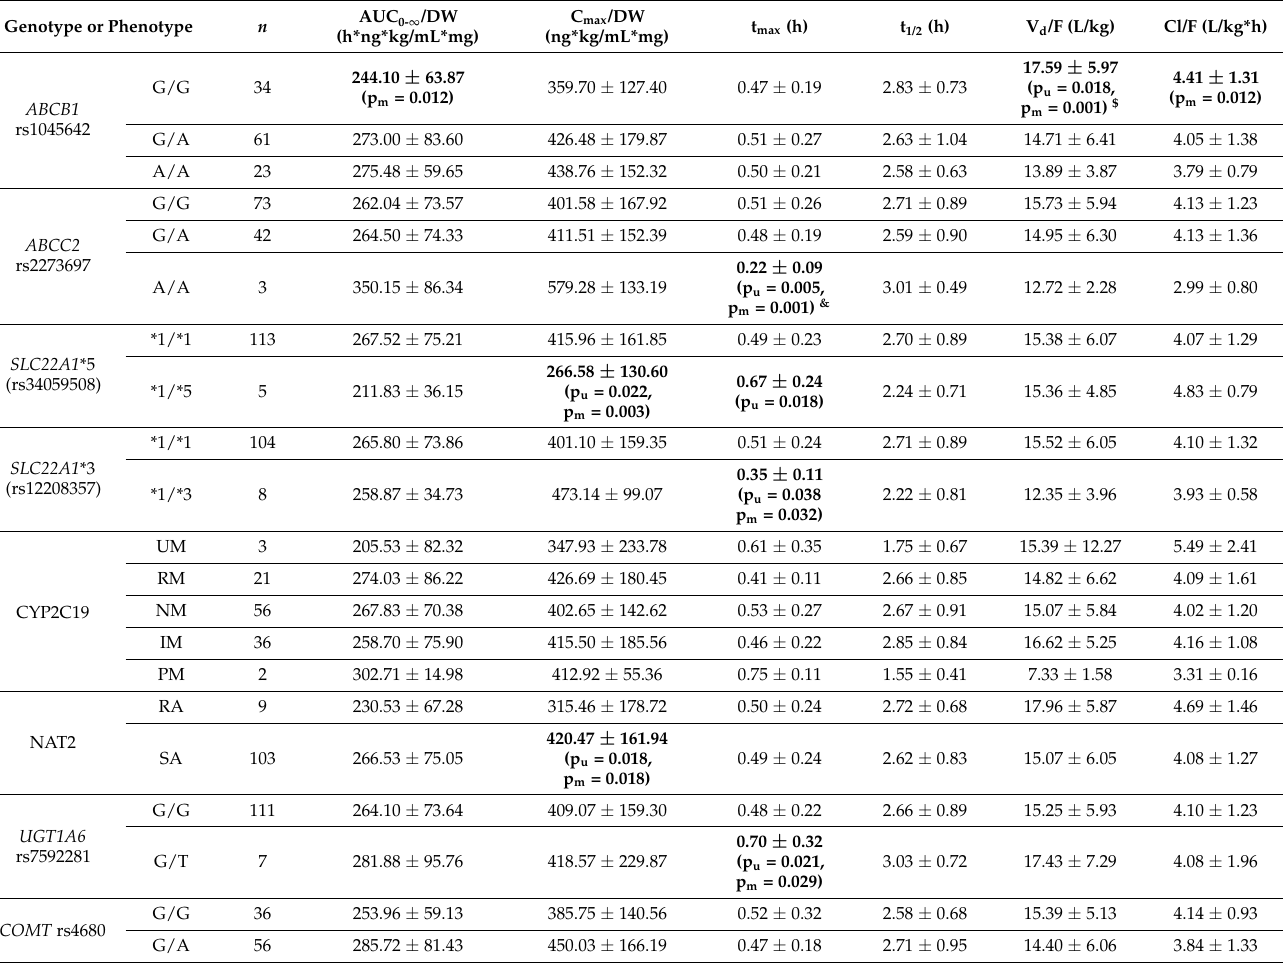
Table 5. Associations between genotypes and phenotypes and the pharmacokinetic parameters of